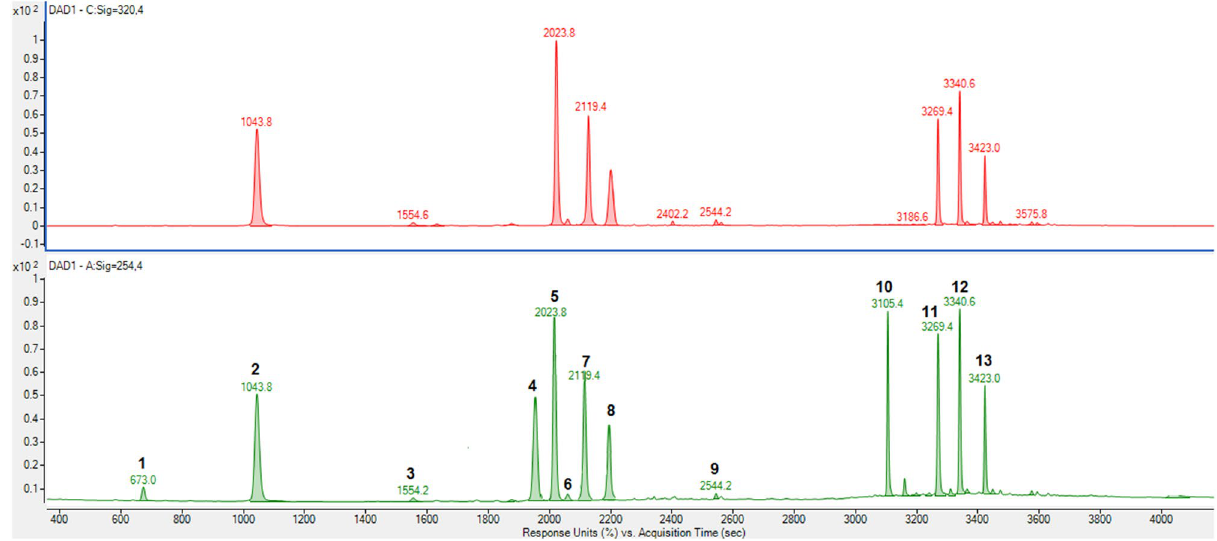
Figure 1. Example extracted ion chromatograms (XIC) obtained for Yerba Mate extract. Names of compounds indicated by numbers (1–13) explained in Table 1.